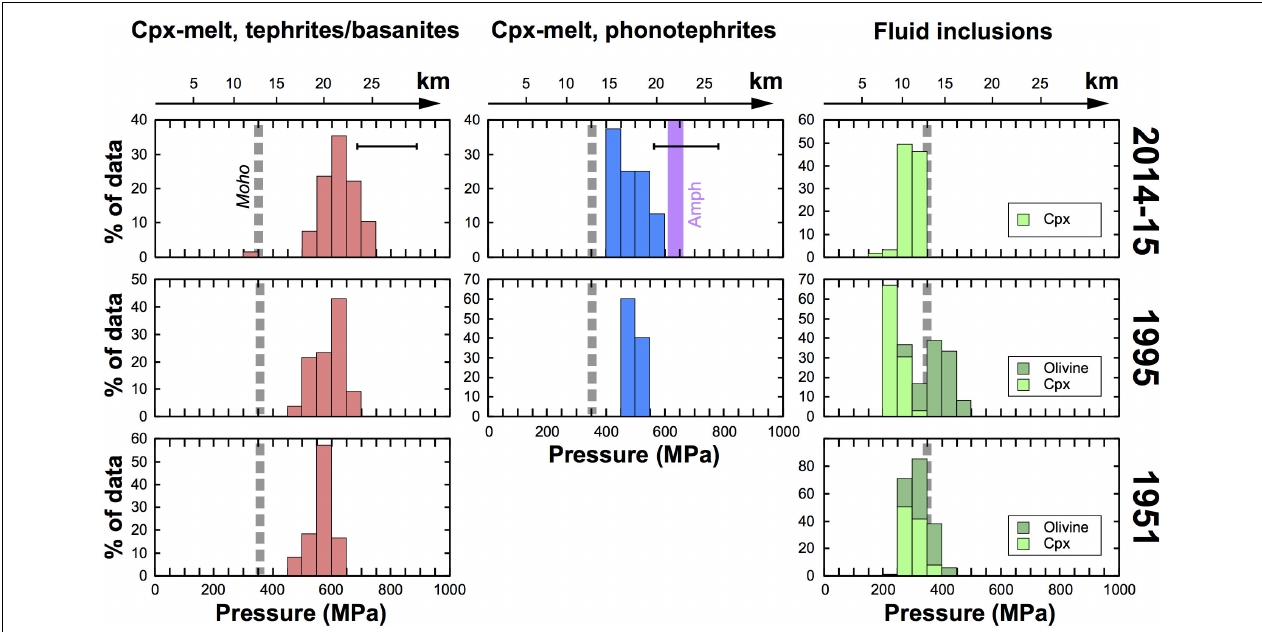
FIGURE 10 | Overview of barometric data for the 2014–2015 eruption (first row), and comparison to data for the preceding 1995 and 1951 eruptions (second and third row; after Hildner et al., 2011, 2012). The diagrams for clinopyroxene-melt barometry display data for phenocryst rims, using the Putirka et al. (2003) calibration and filter 1 as equilibrium test. Shown are the average pressures calculated for each crystal, rather than single analyzed points as in Figure 5 . Horizontal bars mark the data range for clinopyroxene cores from Mata et al. (2017), and vertical bar labeled “Amph” indicates the pressure range obtained for amphiboles in phonotephrites after Ridolfi et al. (2012). During the 1951 eruption no phonotephrite was erupted. The depth of the Moho (dashed thick lines) and the conversion of pressure to depth are based on the crustal model of Pim et al.